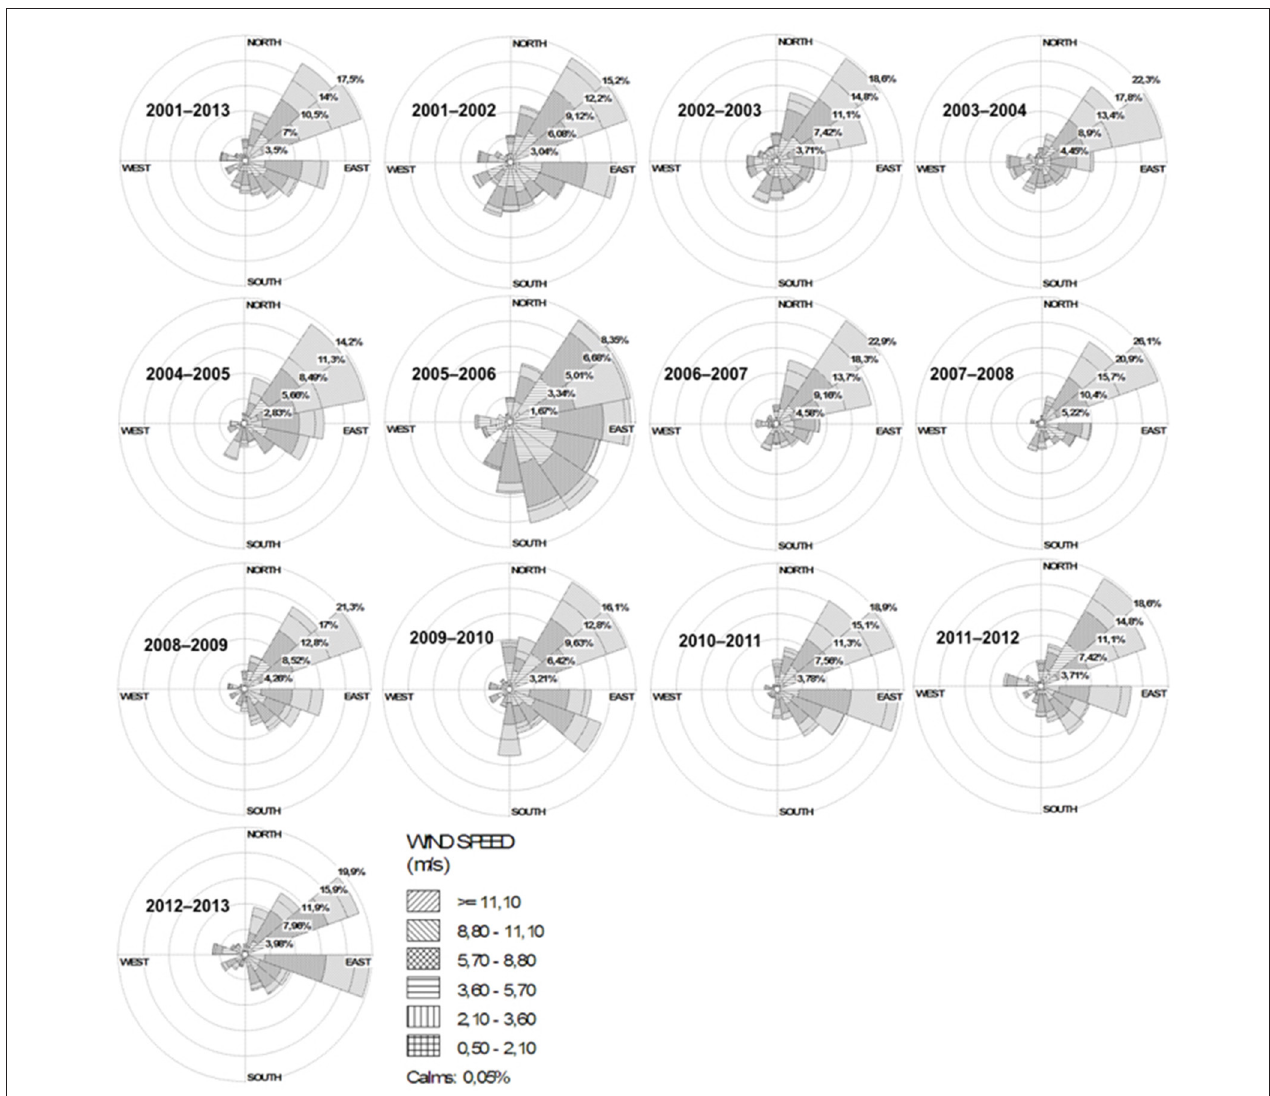
FIGURE 4 | Wind roses chart with wind speed (m s − 1 ) and direction, corresponding to the whole time series of 2001–2013 and, in sequence, from December to February, beginning in the austral summer of December-2001 to February-2002 and ending in the austral summer of December-2012 to February-2013. Note that the wind rose from 2005 to 2006 is very dissimilar to others, but having the N = 860 of valid data points while the other wind roses have valid data points ranging from 2,130 to